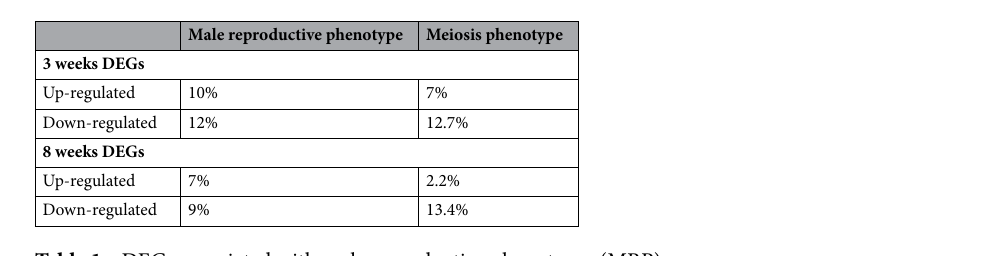
Table 1. DEGs associated with male reproductive phenotypes